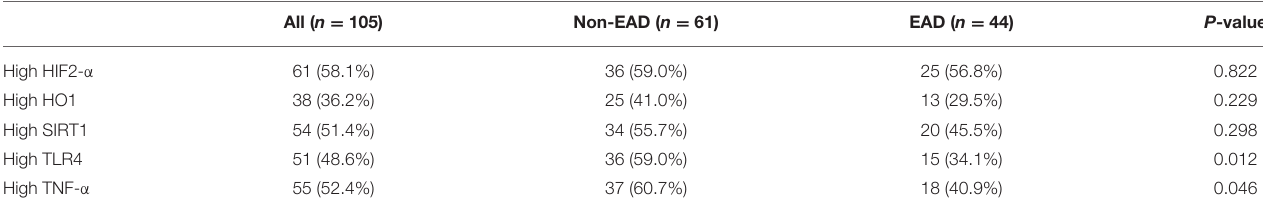
TABLE 2 | Expression levels of protein profiles between EAD and non-EAD groups.